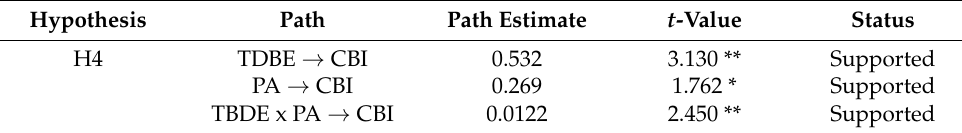
Table 5. Result of moderating